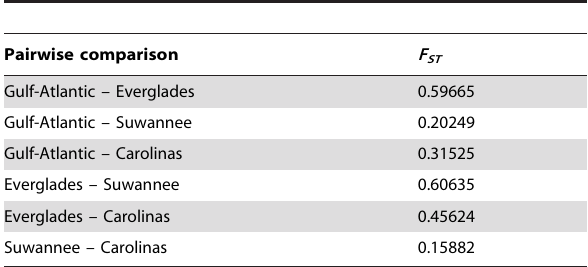
Table 3. Pairwise F ST measured between STRUCTURAMA- inferred populations with nDNA.